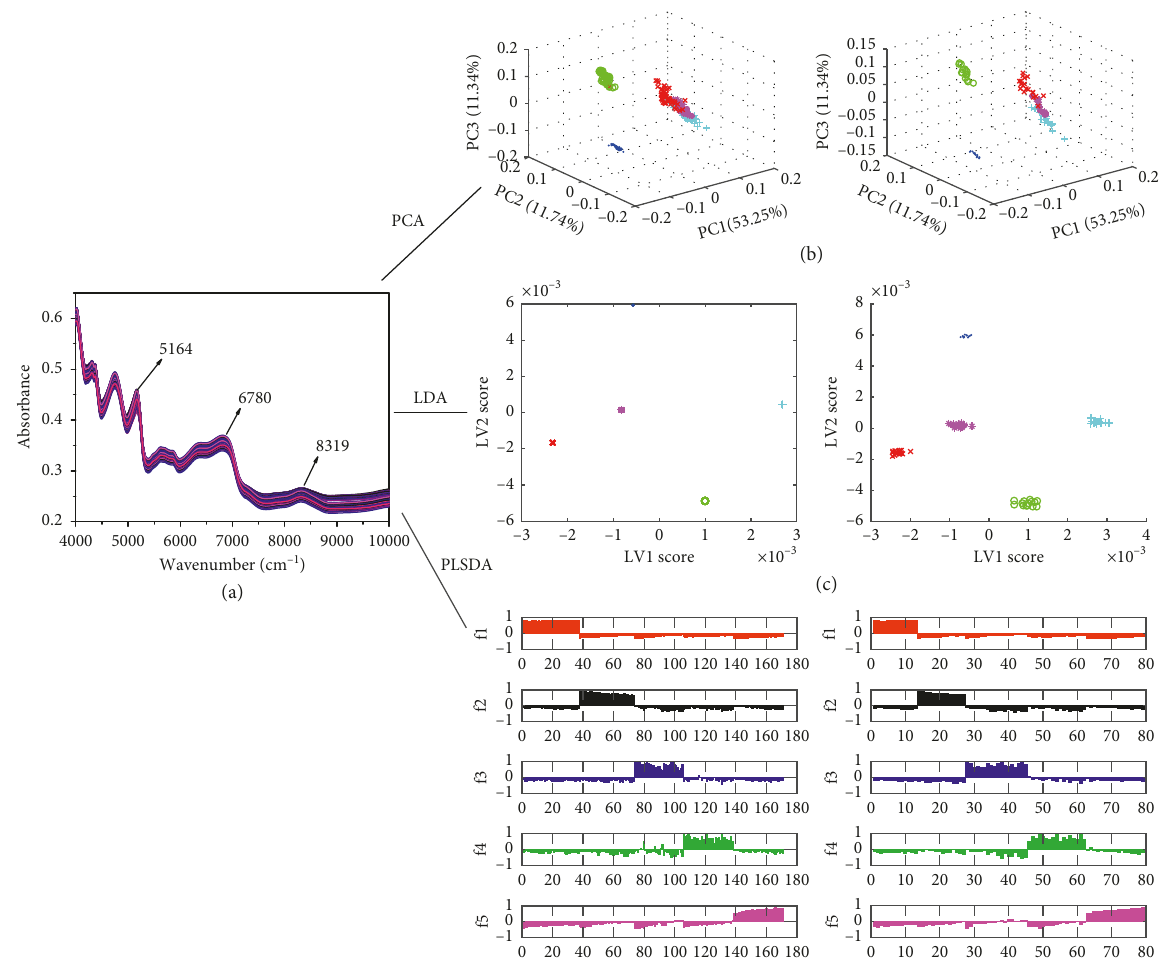
Figure 1: The raw NIR spectra of five different origins of Angelica dahurica (a) and the results by PCA (b), LDA (c), and PLSDA Table 1: A detailed list for the training set and the prediction set of five different kinds of Angelica dahurica samples. Groups code f1 f2 f3 f4 f5 Sample group 1 2 3 4 5 Symbol · ○ × ＋ ∗ PCA, LDA, or PLSDA training set PCA, LDA, or PLSDA prediction set